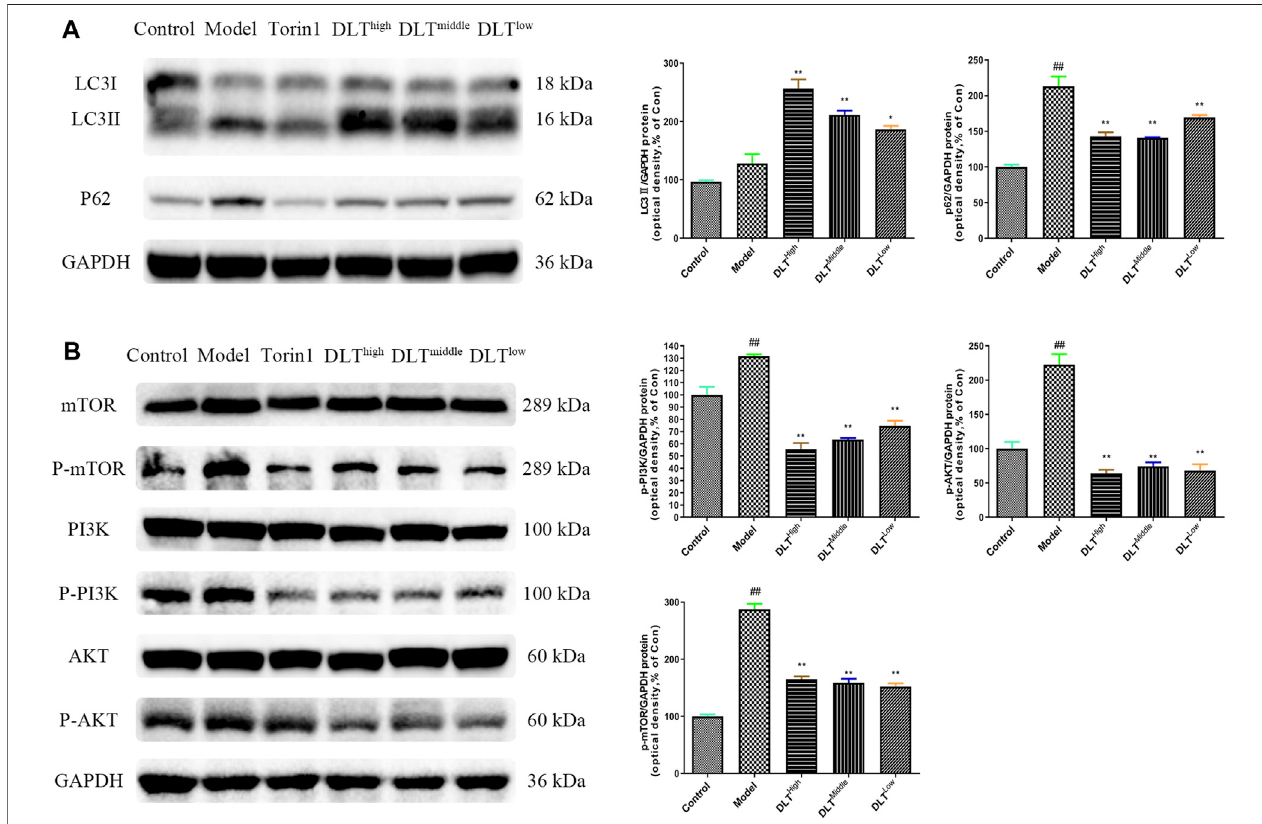
FIGURE 9 | DLTs enhanced autophagy in oxLDL-induced RAW264.7 cells via the PI3K/Akt/mTOR pathway. (A) DLTs upregulated the expression of the autophagy-relatedproteinLC3IIanddecreasedP62accumulation. (B) DLTsdownregulatedtheexpressionoftheautophagy-relatedsignalingmoleculesp-PI3K,p-Akt, and p-mTOR. Thebargraphsshowthequanti fi cationoftheindicatedproteins. Mean ± SD, n (cid:2) 3. ## p < 0.01vsthecontrolgroup,and* p < 0.05, ** p < 0.01vsthemodel